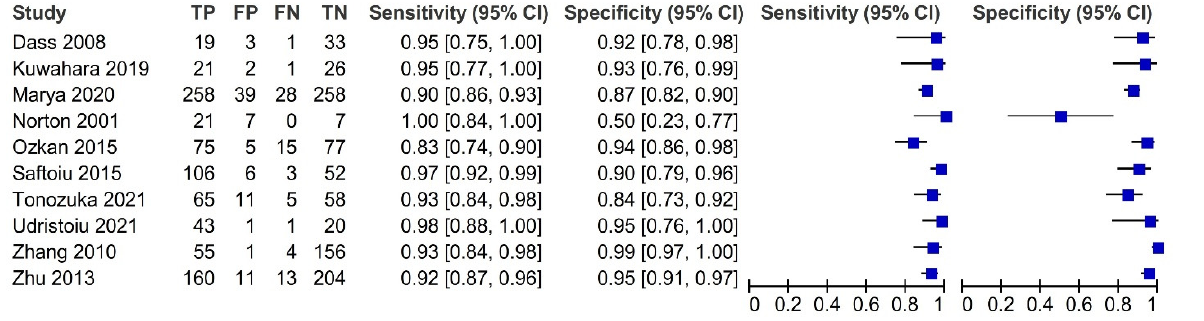
Figure 3. Forest plot with the diagnostic test accuracy (sensitivity, specificity, and 95% confidence interval) of each study for artificial intelligence in the diagnosis of pancreatic cancer.